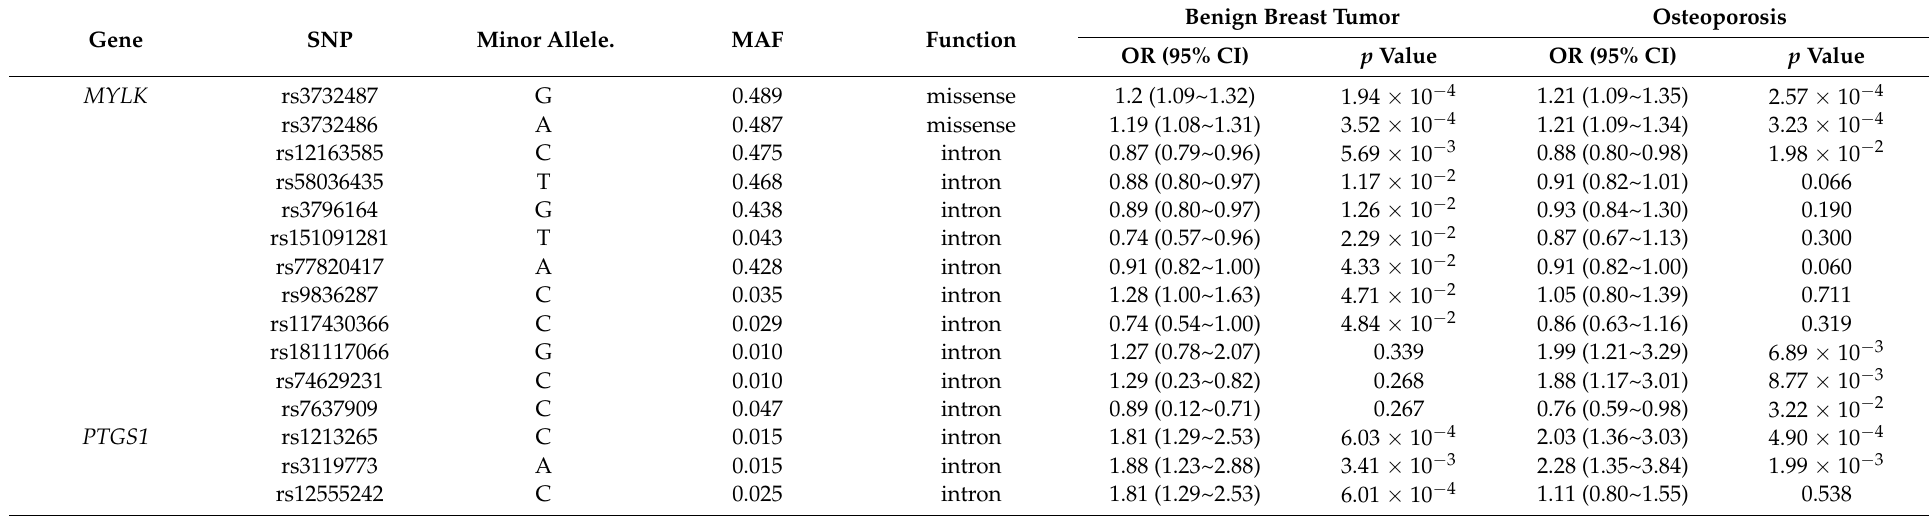
Benign Breast Tumor Osteoporosis OR (95% CI) p Value OR (95% CI) p Value